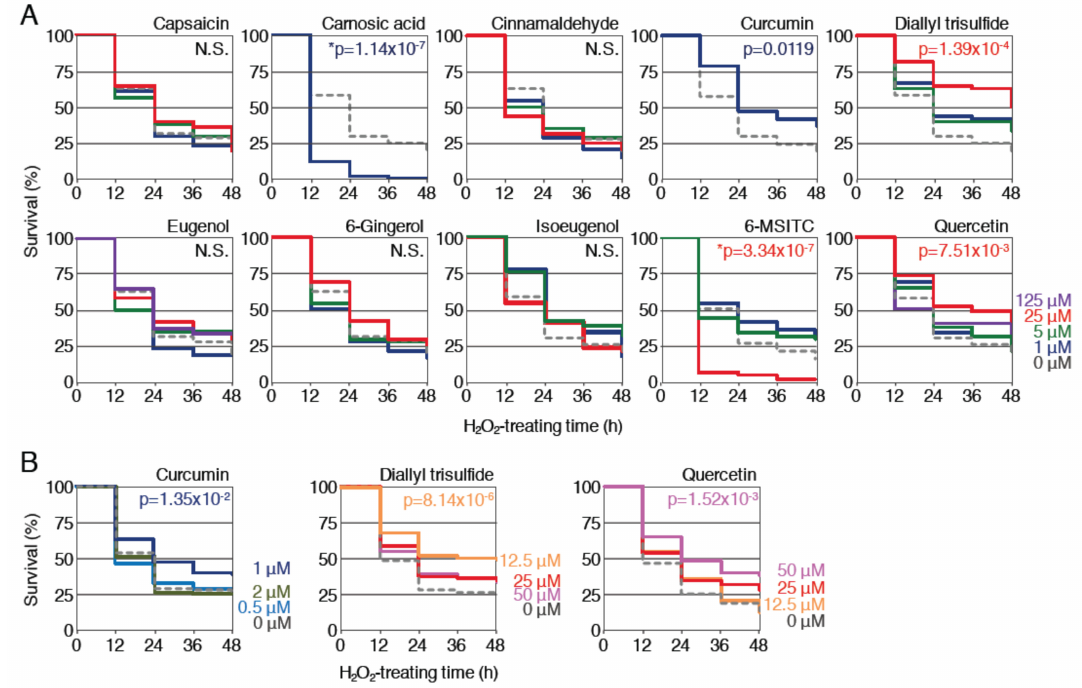
Figure 2. E ff ects of pretreatment with spice-derived phytochemicals on the survival rates of zebrafish larvae exposed to H 2 O 2 . ( A ) Survival assays using 10 phytochemicals at 4 concentrations. Larvae (3.5 dpf) were pretreated with the indicated phytochemicals at concentrations of 0 µ M (gray, dotted), 1 µ M (dark blue), 5 µ M (green), 25 µ M (red) or 125 µ M (purple). After pretreatment for 12 h, the solution was changed to 2.8 mM H 2 O 2 and survival was measured every 12 h for 48 h. Each analysis was performed in triplicate, and the experiments were repeated multiple times. ( B ) Optimization of the concentration of phytochemicals. Larvae (3.5 dpf) were pretreated with curcumin (0 (gray, dotted), 0.5 (light blue), 1 (dark blue), 2 µ M (dark green)), diallyl trisulfide (0 (gray, dotted), 12.5 (orange), 25 (red), 50 µ M (pink)) or quercetin (0 (gray, dotted), 12.5 (orange), 25 (red), 50 µ M (pink)) at the indicated concentrations. All survival rates were calculated using the Kaplan–Meier method and analyzed by log-rank test; p values of < 0.05 were considered to indicate statistical significance. Asterisks denote toxic e ff ects of the indicated phytochemicals. N.S. indicates not